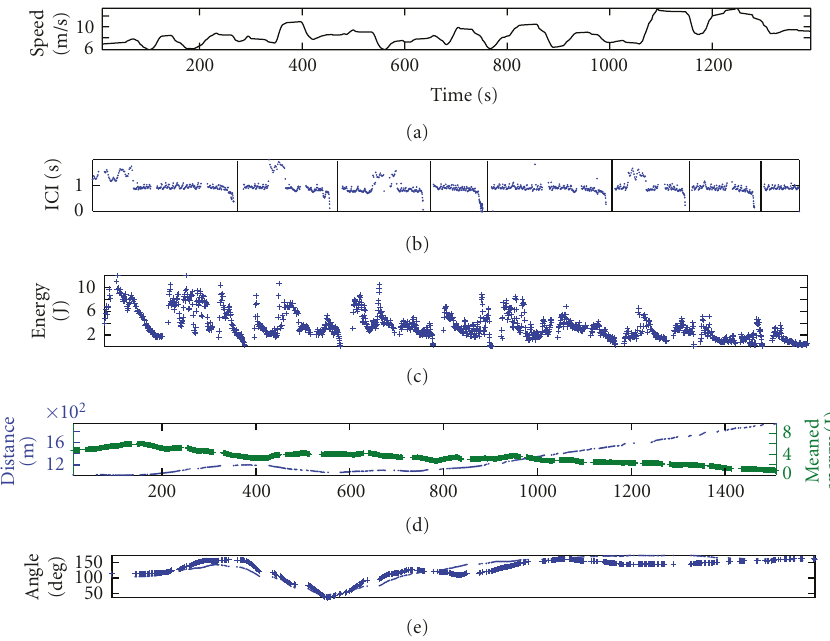
Figure 4: All features versus time of recording in dataset 2. (a) Speed of the whale. (b) ICI. Lines in (b) underline ingestions of the preys. (c) Energy of the clicks. In (d), distance ( · ) and meaned energy (+) are plotted, so we can see the influence of the distance to the energy bias, and the energy decreases while the distance increases. (e) Theta1 (+), Theta2 ( · ). Theta angles are smoothed on 10s windows, so we cannot notice yaw and pitch variation, visible at 1s